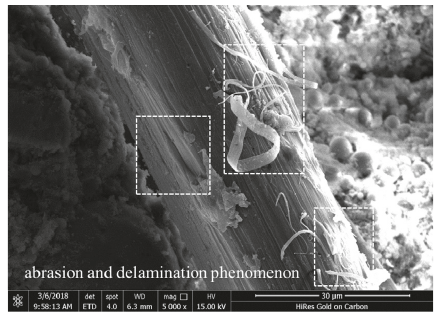
Figure 2: The abrasion and delamination